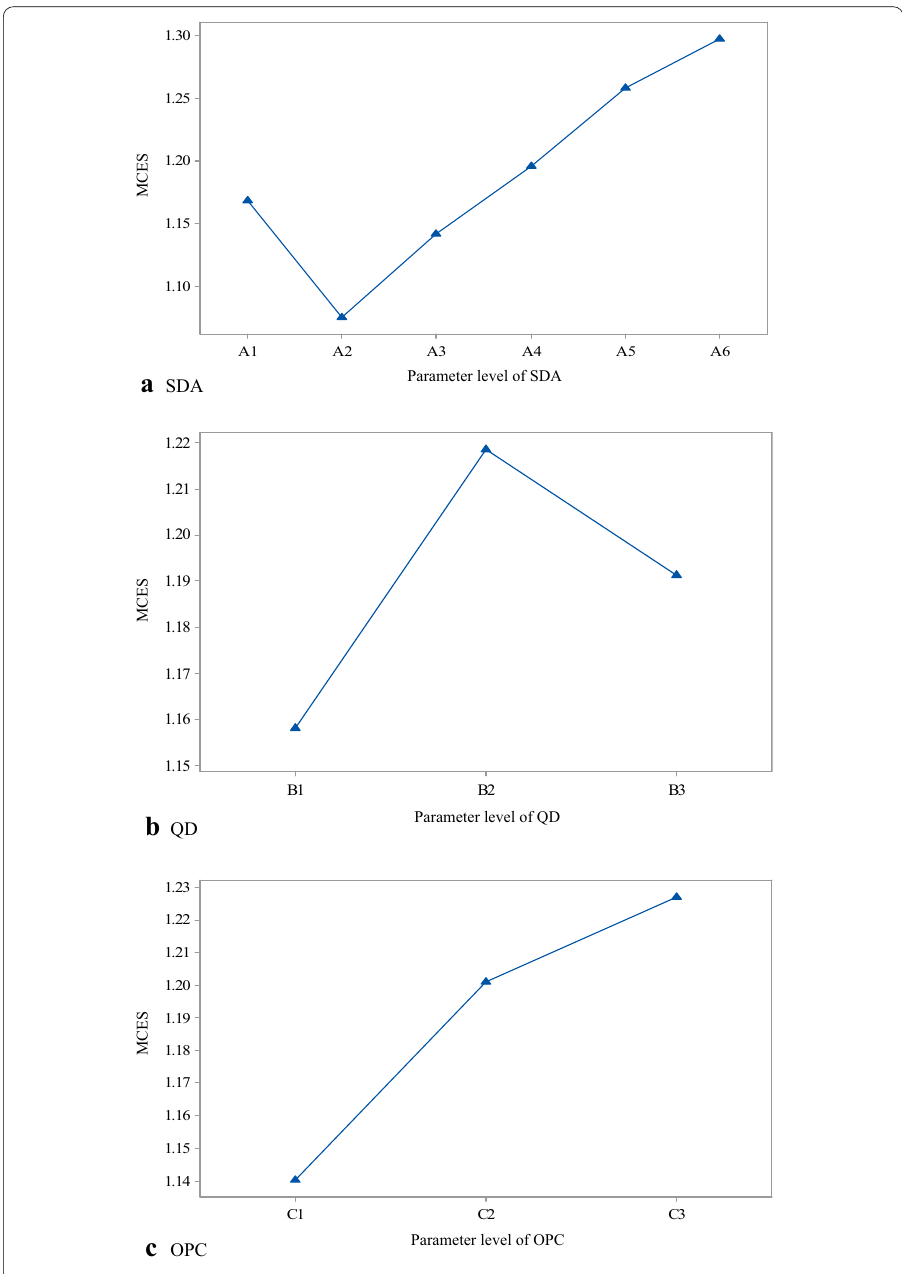
Fig. 3 a – c Plots of parameter level effect on MCES